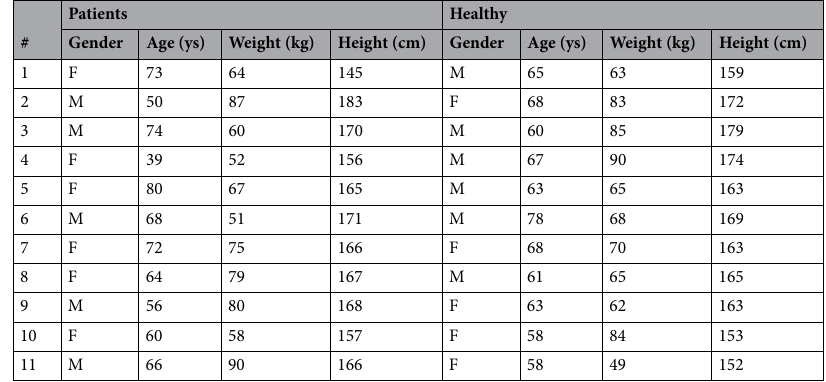
Table 1. Anthropometric data for the patients with COPD and healthy individuals enrolled in this